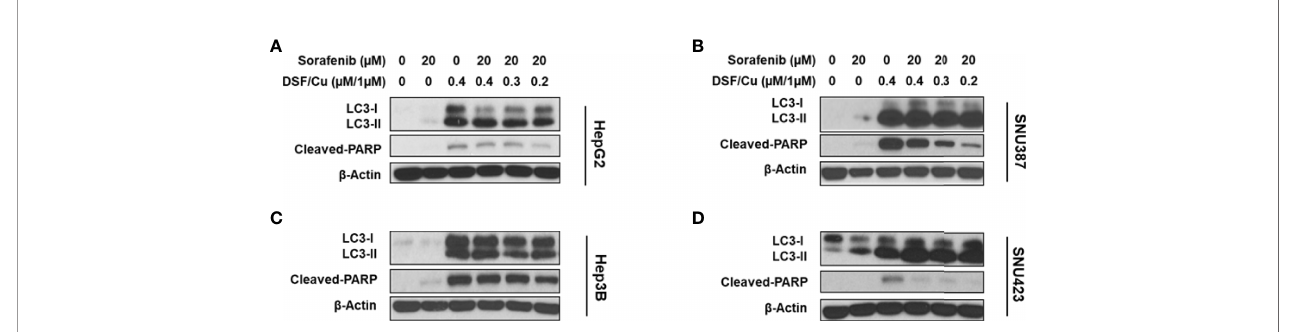
FIGURE 4 | DSF/Cu and sorafenib induce autophagy and apoptosis of HCC cells. The HCC cell lines HepG2 (A) , SNU387 (B) , Hep3B (C) , and SNU423 (D) were treated as indicated for 24 h. Treated cells were lysed to detect levels of LC3-II/LC3-I and cleaved PARP by western blot